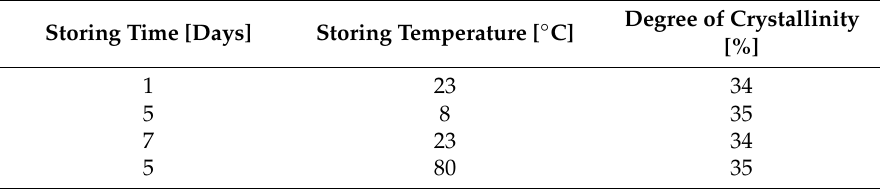
Table 2. Degree of Crystallinity of PP after conditioning at various parameters.